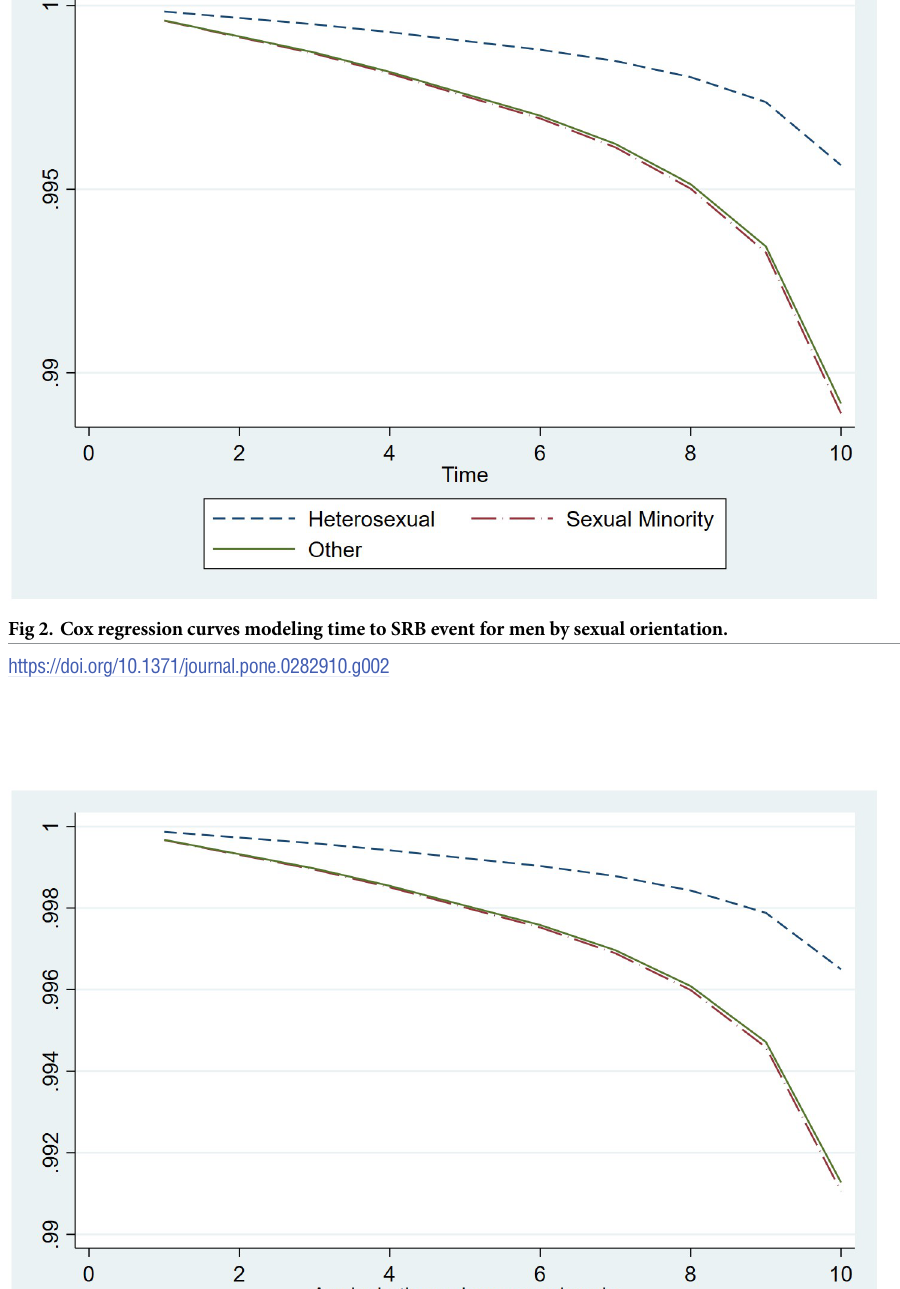
PLOS ONE | https://doi.org/10.1371/journal.pone.0282910 March 29,